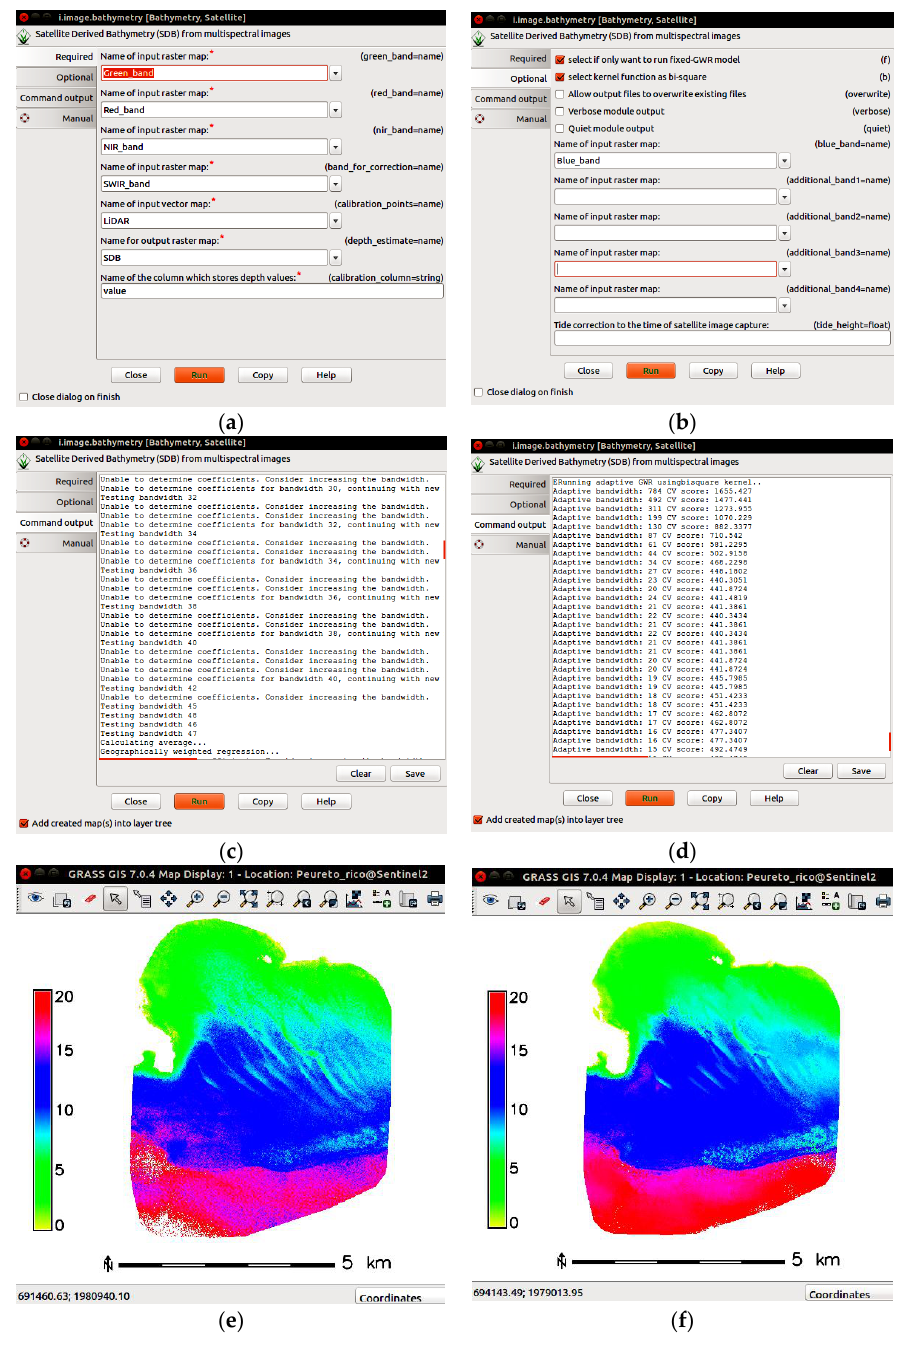
Figure 5. These screenshots demonstrate the input options and processing of i.image.bathymetry using an example from case study 1, ( a ) required input bands; ( b ) optional input bands and optional flags selected for Fixed-GWR; ( c ) optimal bandwidth estimation for Fixed-GWR; ( d ) optimal bandwidth estimation for A-GWR; and ( e ) SDB estimated from Fixed-GWR and ( f ) SDB estimated from A-GWR.